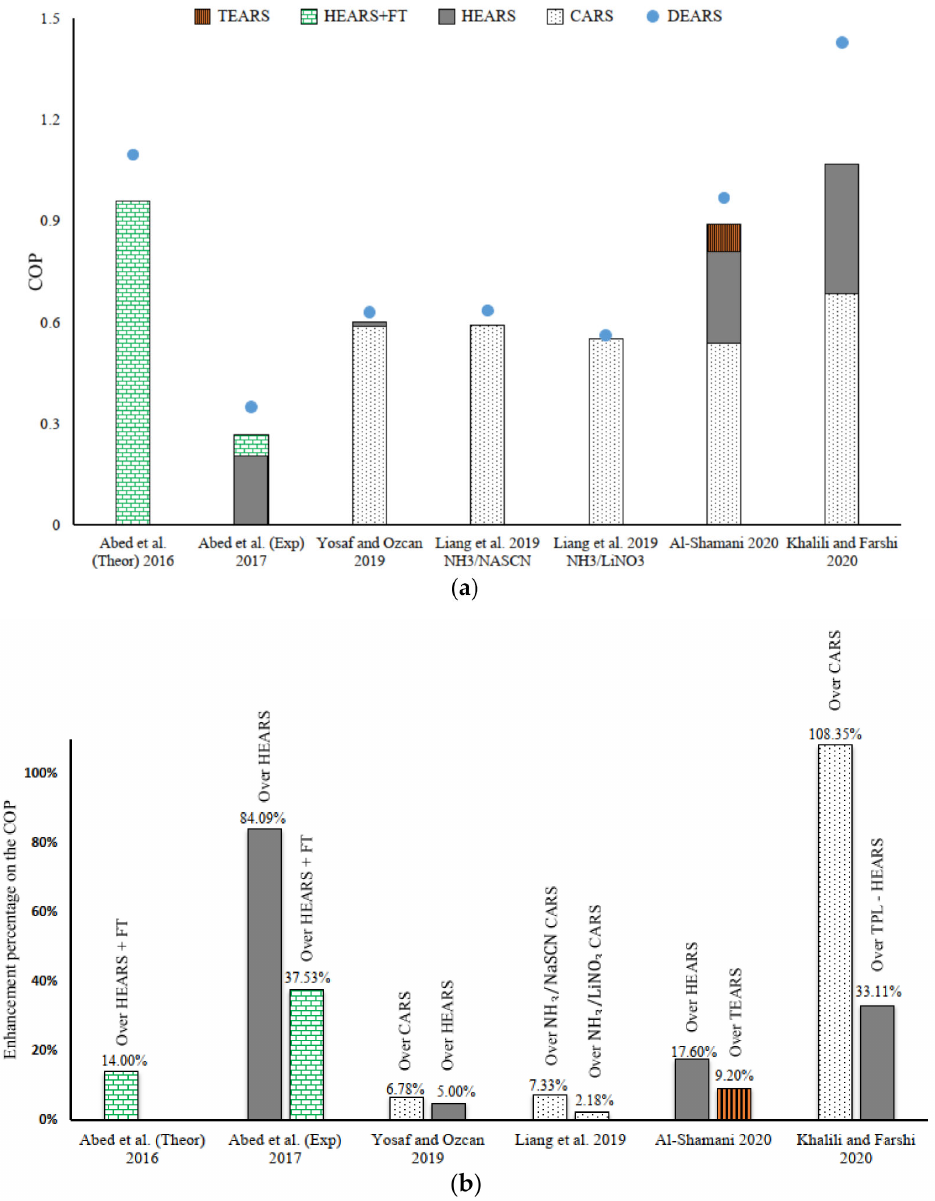
Figure 16. ( a ) Comparison between different configurations of DEARS and different absorption refrigeration systems; ( b ) improvement percentages of DEARS over various configurations of absorption refrigeration